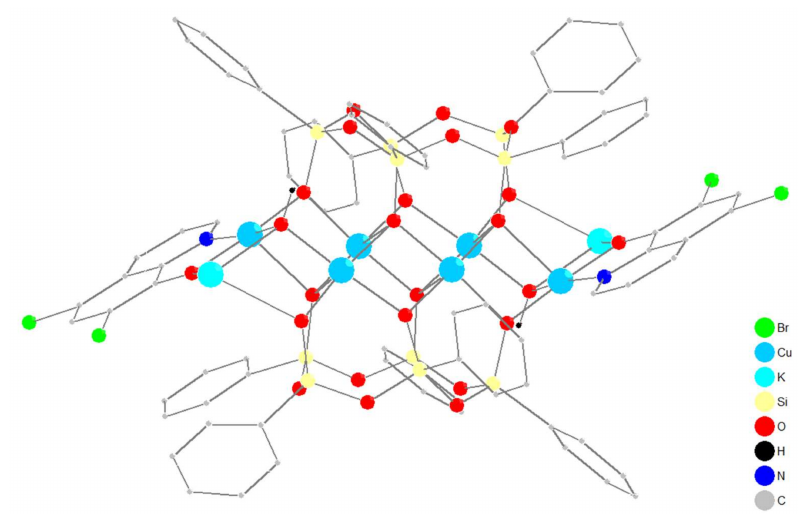
Figure 6. Top . The molecular structure of 6 . Middle. The molecular structure of 7 . Bottom . The molecular structure of 8 .